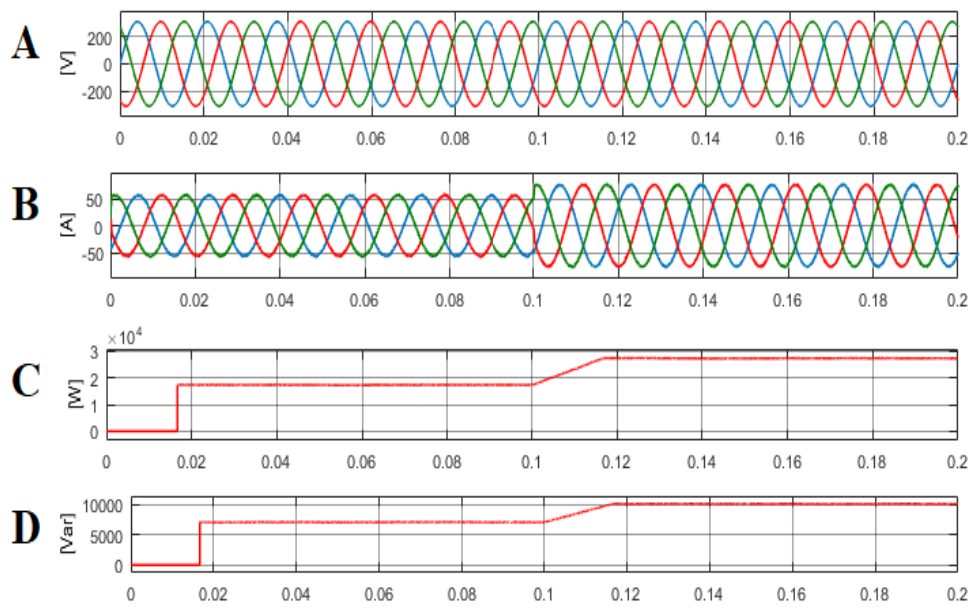
Figure 11. Simulation validation of proposed control strategy with the change of reference ( A ) Voltage waveform fundamental voltage amplitude: 318 V ( B ) load current waveform ( C ) Active power provided by VSC in “W”. ( D ) Reactive power provided by VSC in “VAR”.